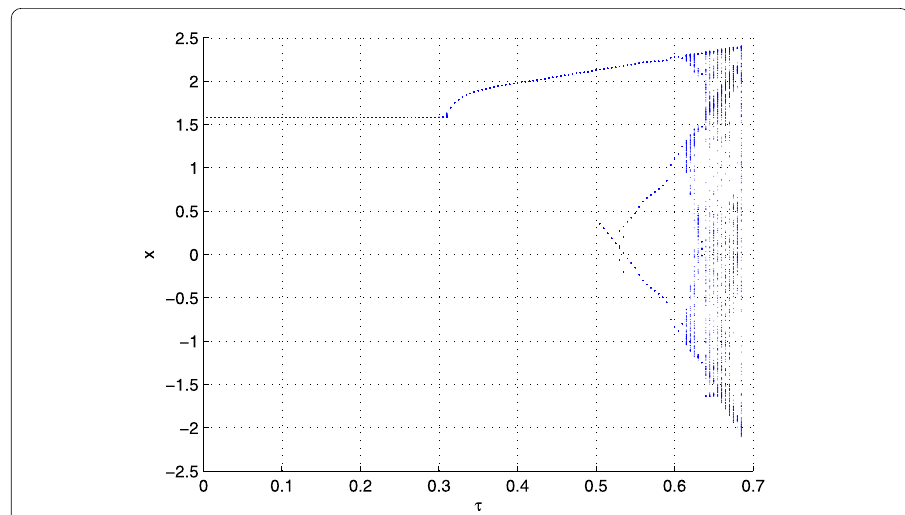
Figure 12 The bifurcation diagram of system (17) with the parameter γ = 3